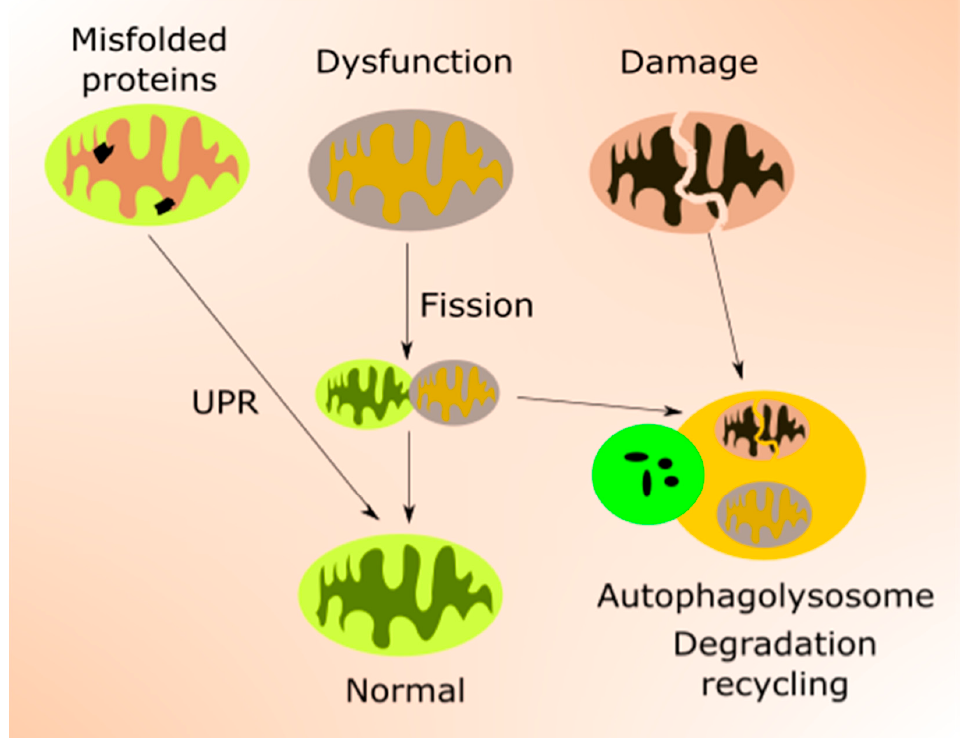
Figure 2. Mitochondrial quality control (mtQC) pathways repair and eliminate impaired mitochondria. Misfolded or unfolded proteins in mitochondria can be refolded by unfolded protein response (UPR). Dysfunctional mitochondria can be sequestered by fission and structurally damaged mitochondria eliminated by mitophagy, a specialized form of autophagy. Mitochondrial biogenesis, an important element of mtQC, is not presented in this figure.